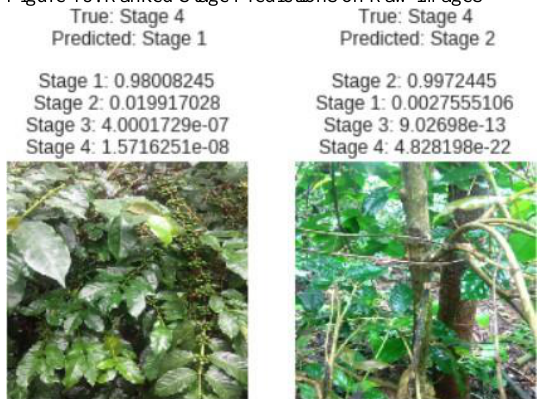
Figure 14. Ranked Predictions on Raw Images. False predictions give hints on how the features extracted by